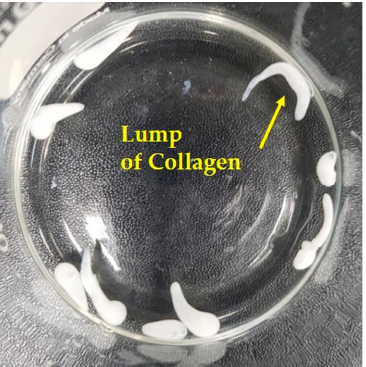
Figure 8. Optical image showing the lumps of collagen synthesized using conventional emulsion technique.